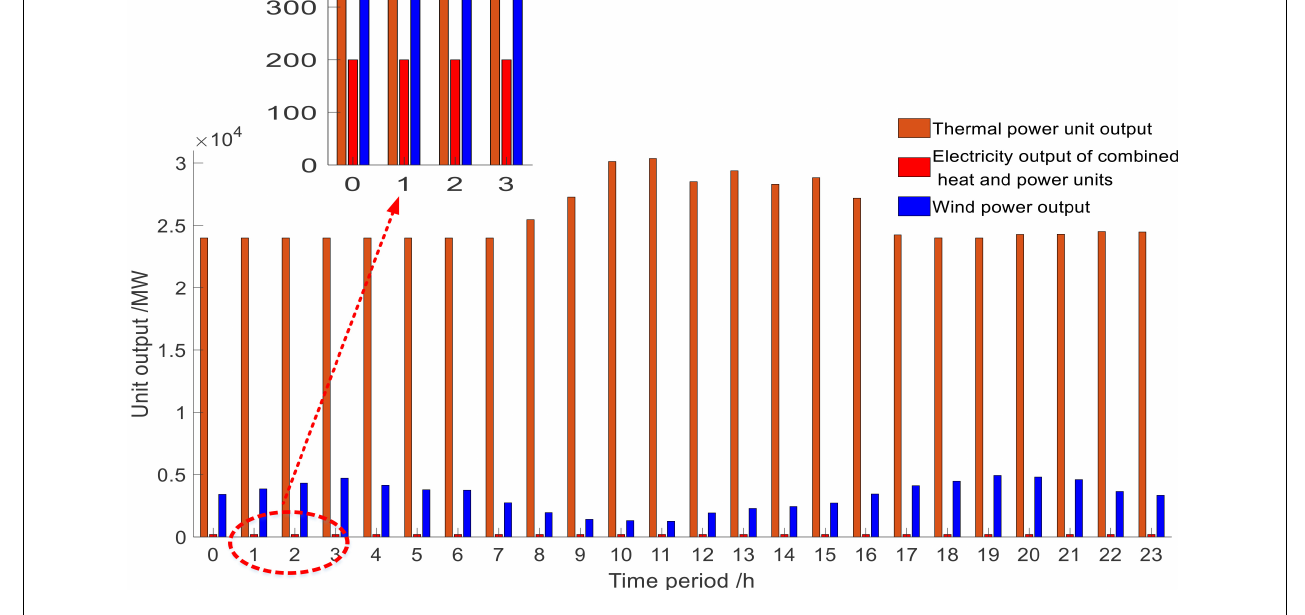
FIGURE 12 | Units output in mode 1.